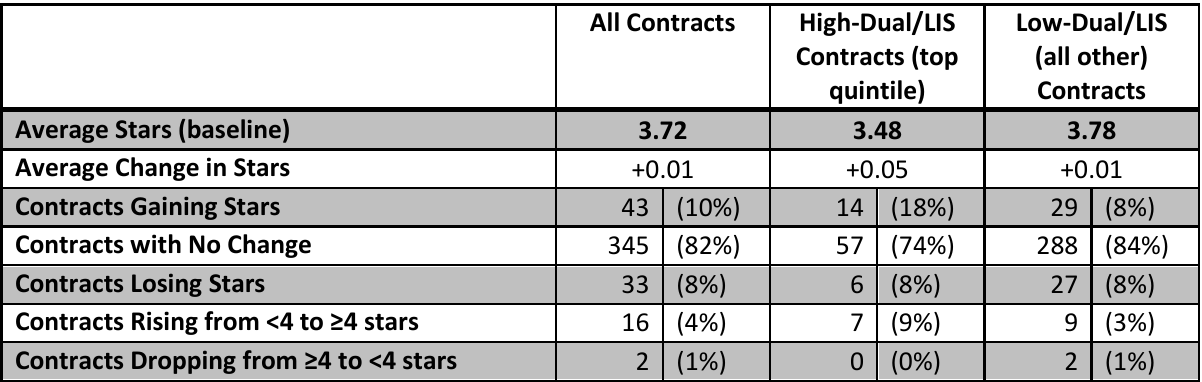
Table 8.14: Upweighting Improvement to 25% of the Quality Star Rating